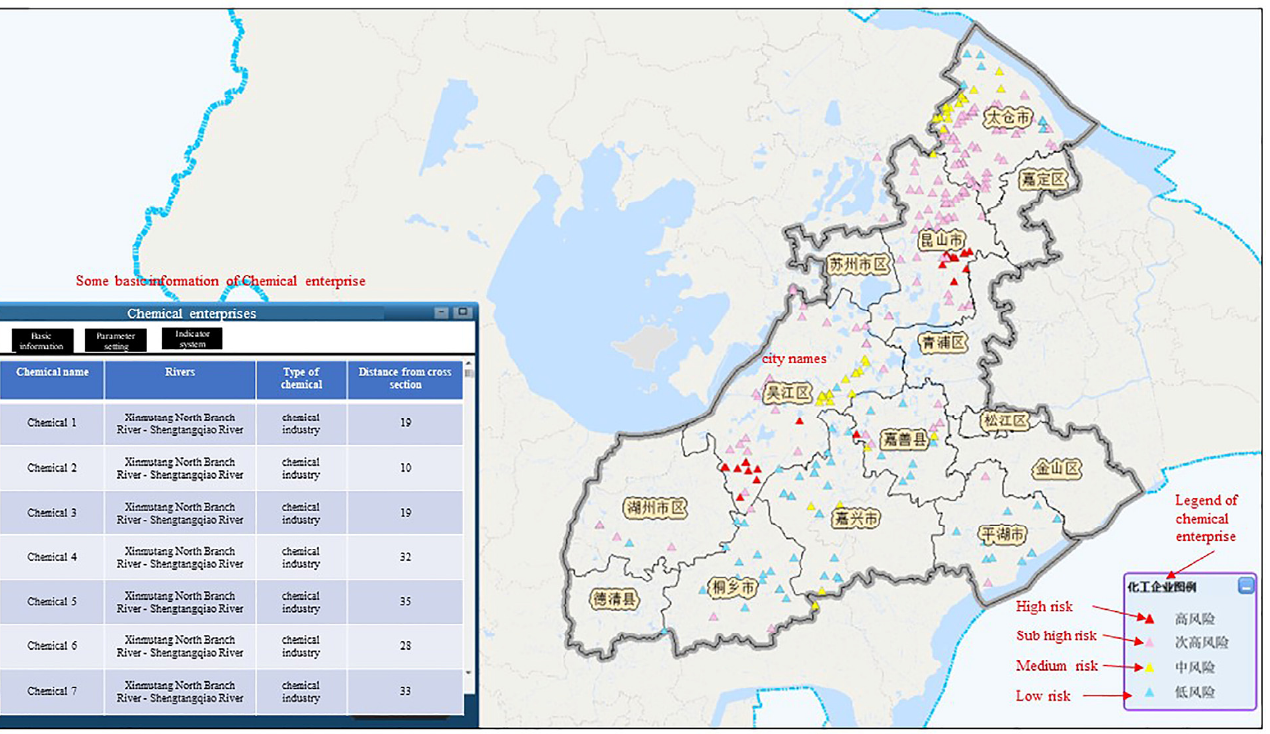
Figure 10. Risk classification of chemical storage sites in the transboundary zones.